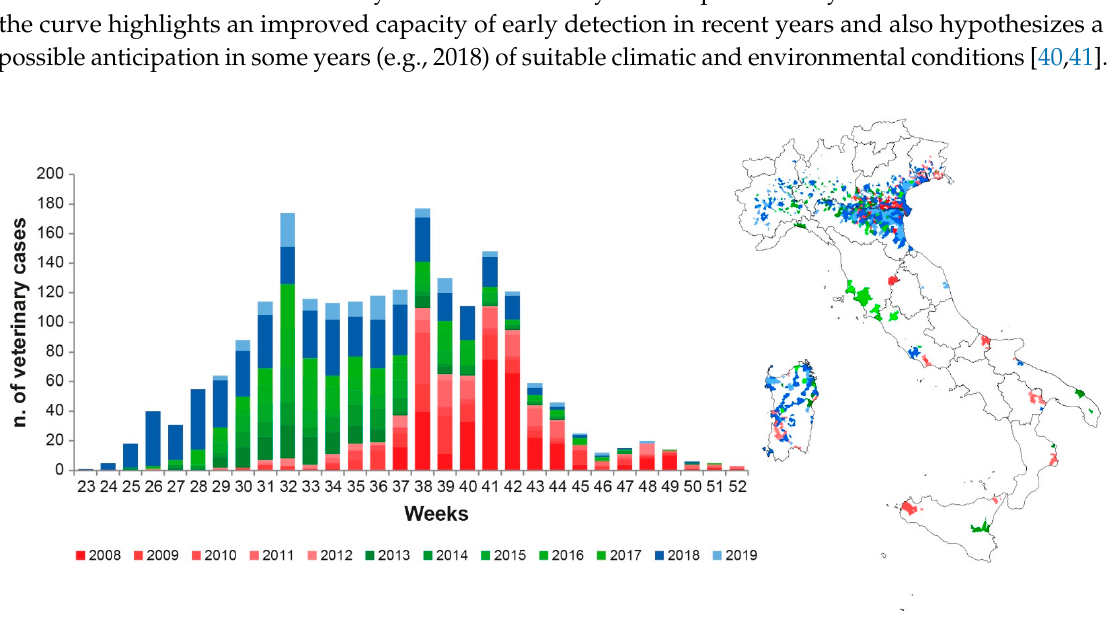
Figure 2. Spatial and temporal distribution of veterinary cases as notified in the O ffi cial Notification System of the Italian Ministry of Health from 2008 to